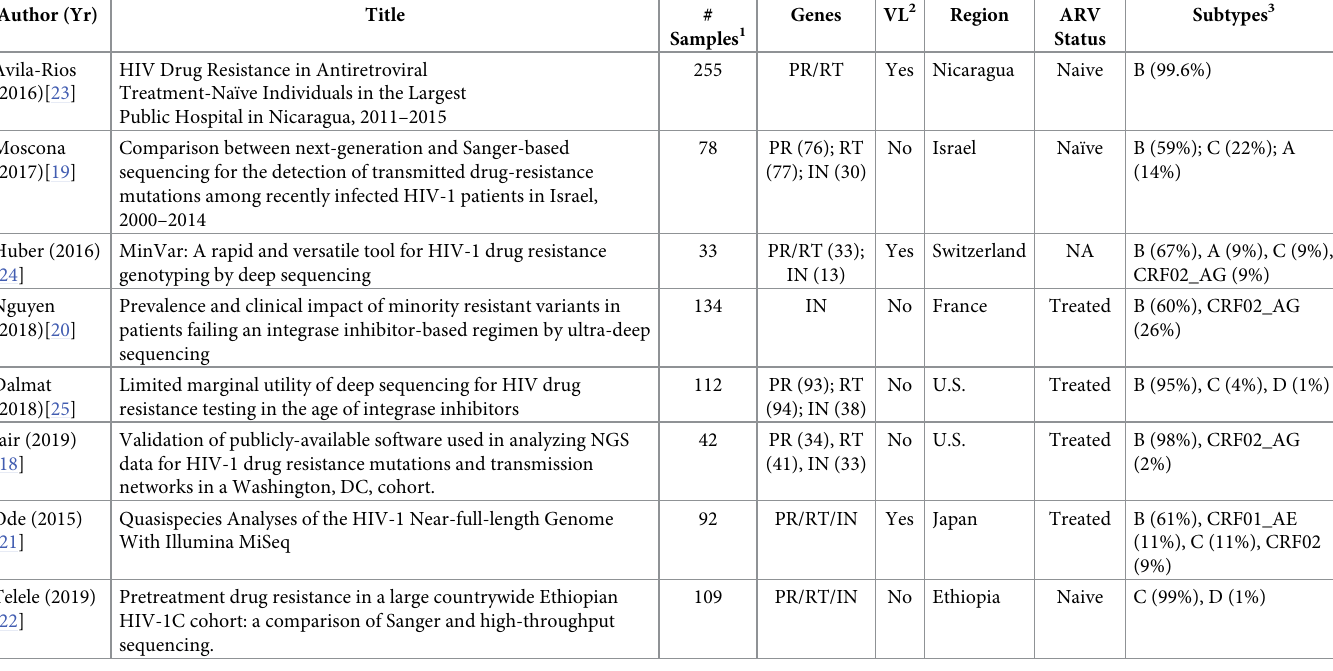
Table 1. Published studies with available HIV-1 pol NGS